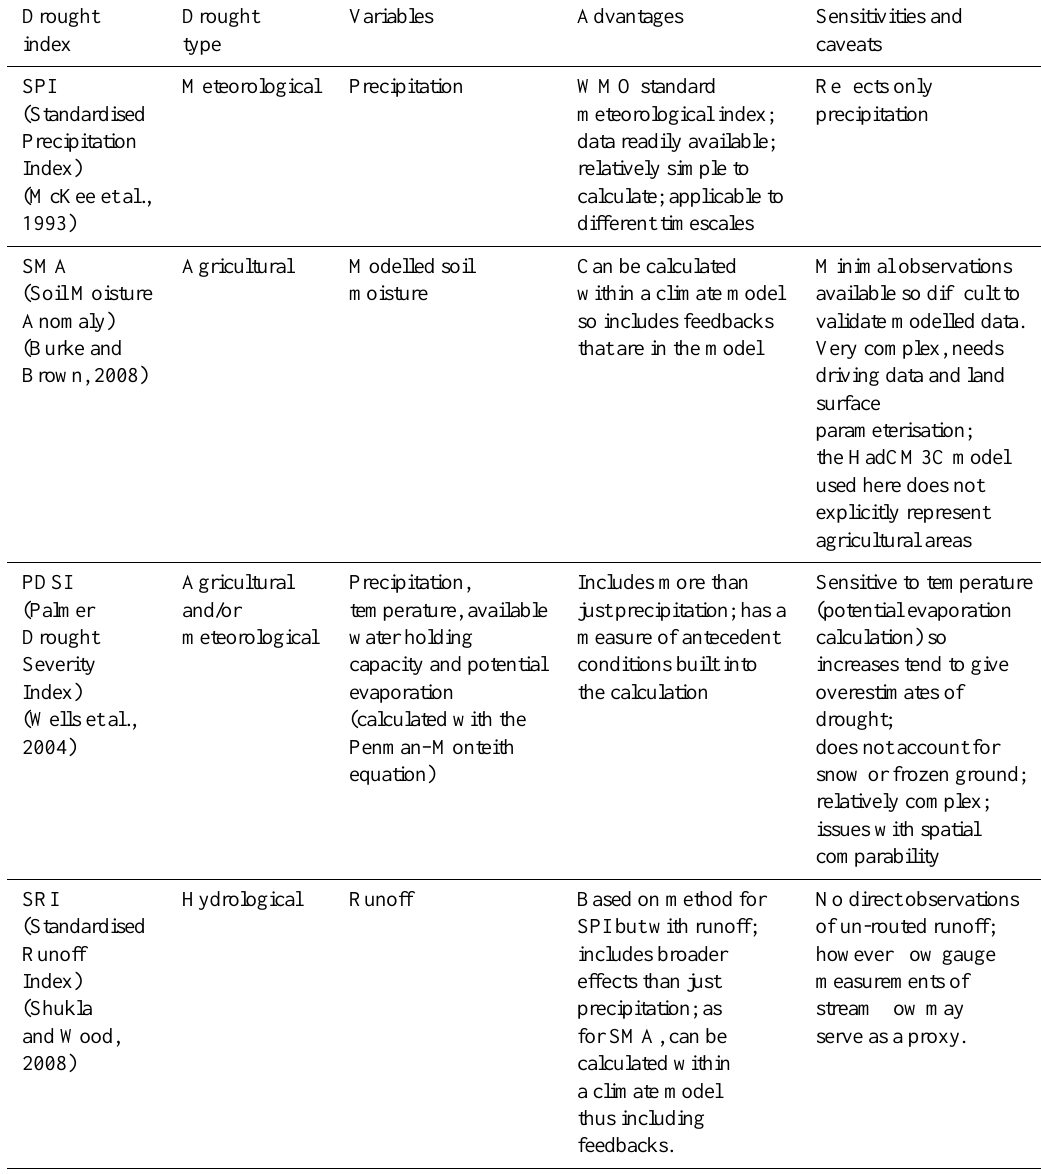
Table 2. Summary of the three drought indices applied in this